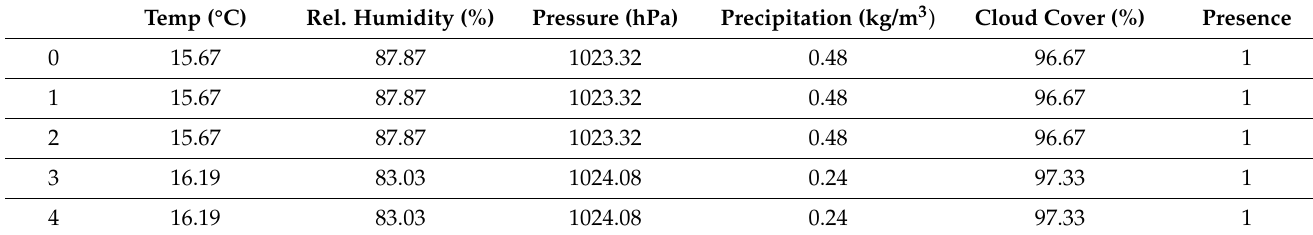
Table 1. First 5 rows of training data.